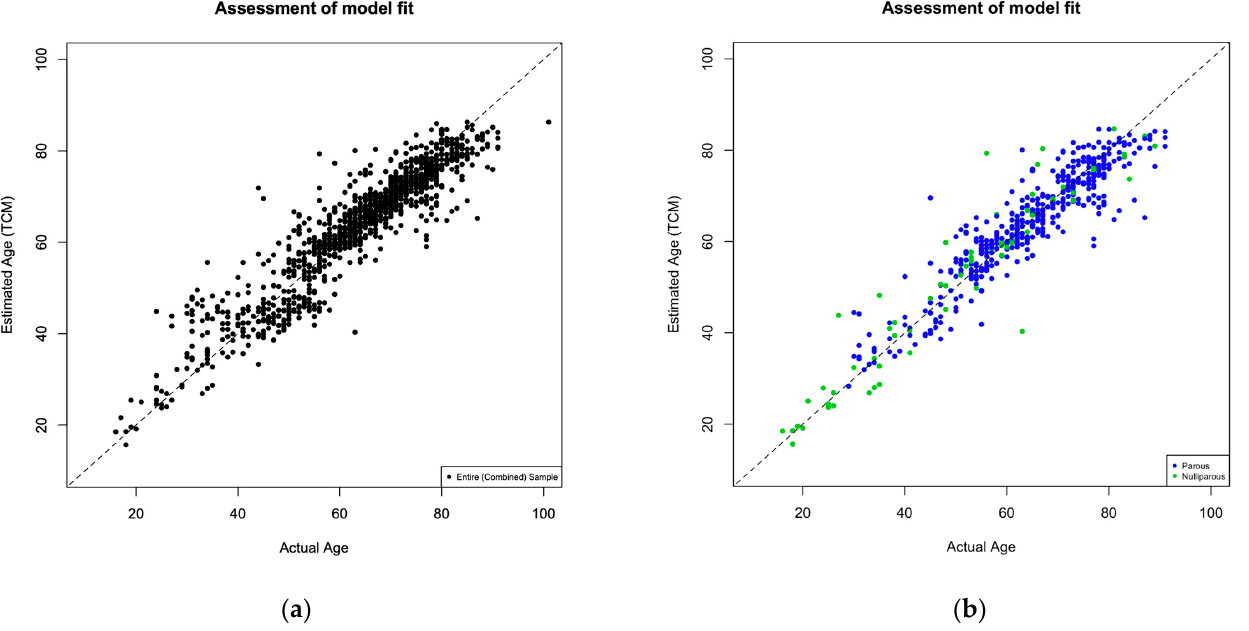
Figure 13. Assessment of model fit: ( a ) Entire sample ( n = 1156); ( b ) Females only ( n = 533). Inaccuracy by decade ranged from 2.04 years (18–29 age group) to 7.71 years (30–39 age group). Bias by decade ranged from − 0.46 years (60–69 age group) to 7.50 years (30– 39 age group). Results by decade are presented in Table 6.